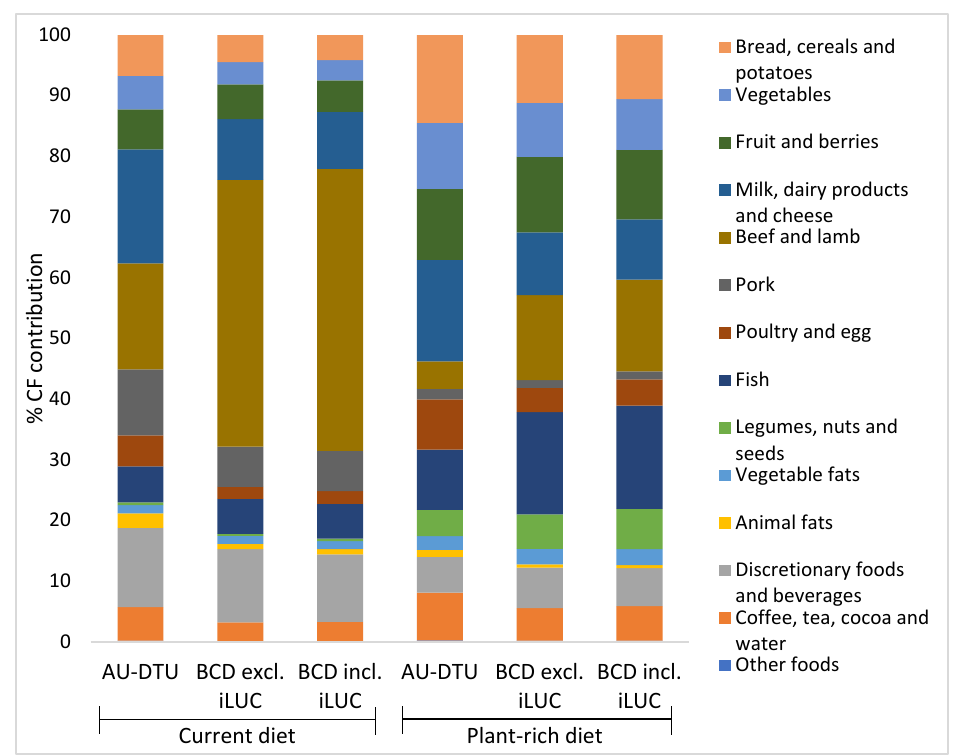
Figure 1. Proportion (%) of the total carbon footprint (CF) from selected food groups in the current diet and the plant-rich diet (10 MJ), and estimated based on three sets of CF data (AU-DTU and BCD +/ − iLUC). System boundary is at the retail gate. The current food intake: The Danish National Survey on Dietary habits and physical Activity (DANSDA) 2011–2013, adults 18–64 years [24]. The food intake of the plant-rich diet: Lassen et al. 2020 [9]. The AU-DTU data are compiled by researchers from Aarhus University and DTU (Technical University of Denmark) described in methodological Section 2.3 of the present study. The Big Climate Database (BCD): published by the Danish green think tank CONCITO [23] described in [18]. iLUC: indirect land use change.